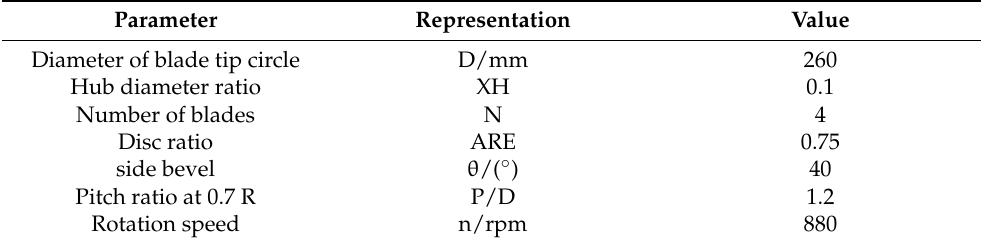
Table 1. Main parameters of the